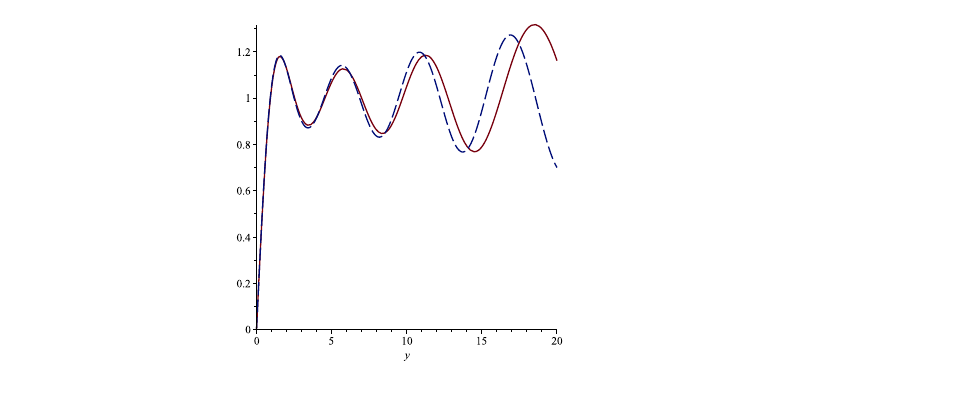
Figure 3. Approximations Φ l 7 (0 ,y ;1) (solid line) and Φ l 9 (0 ,y ;1) (dashed line) to the function Φ (0 ,y ;1)